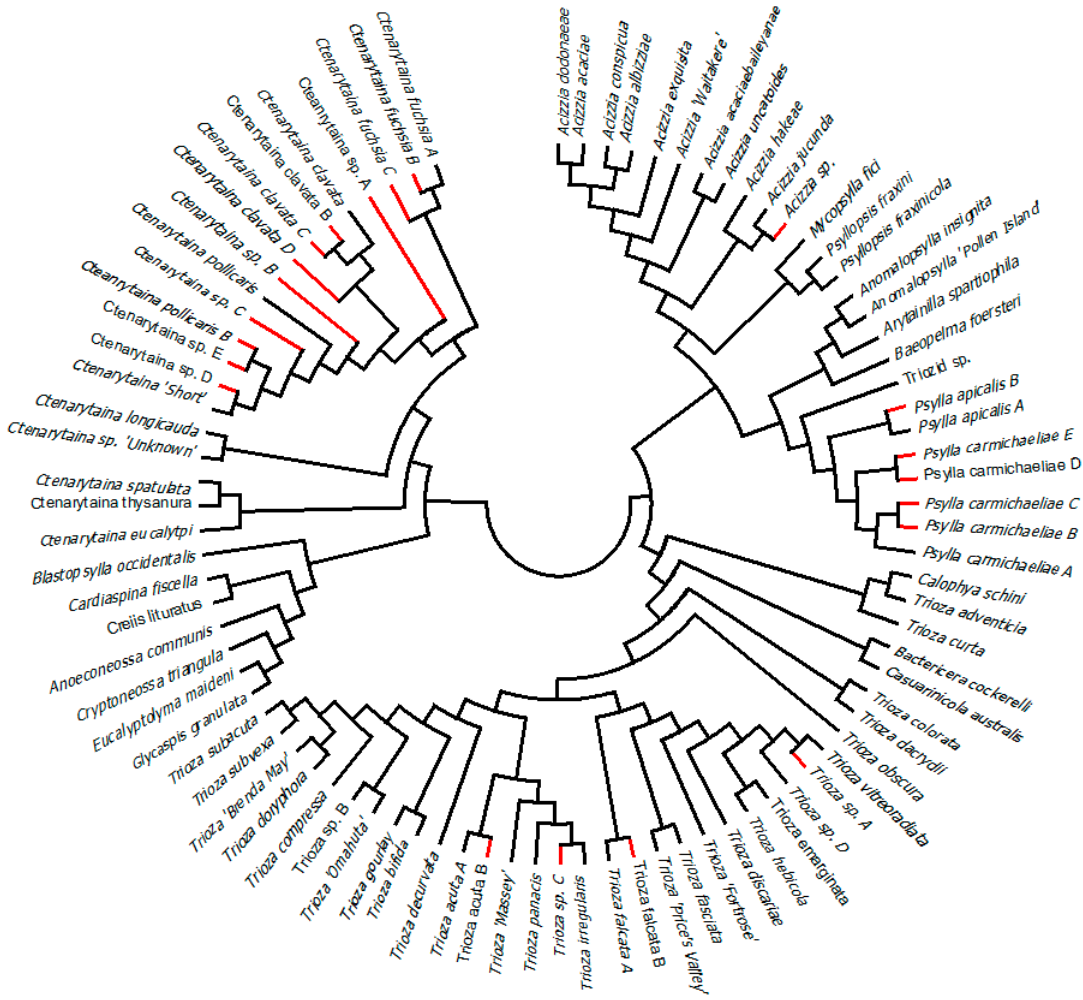
Figure 2. Graphic representation of the COI gene tree reported in Figure S1. The tree has been collapsed to show the 90 taxa presented in this work and their names. Red branches indicate the 21 taxa reported here for the first time.